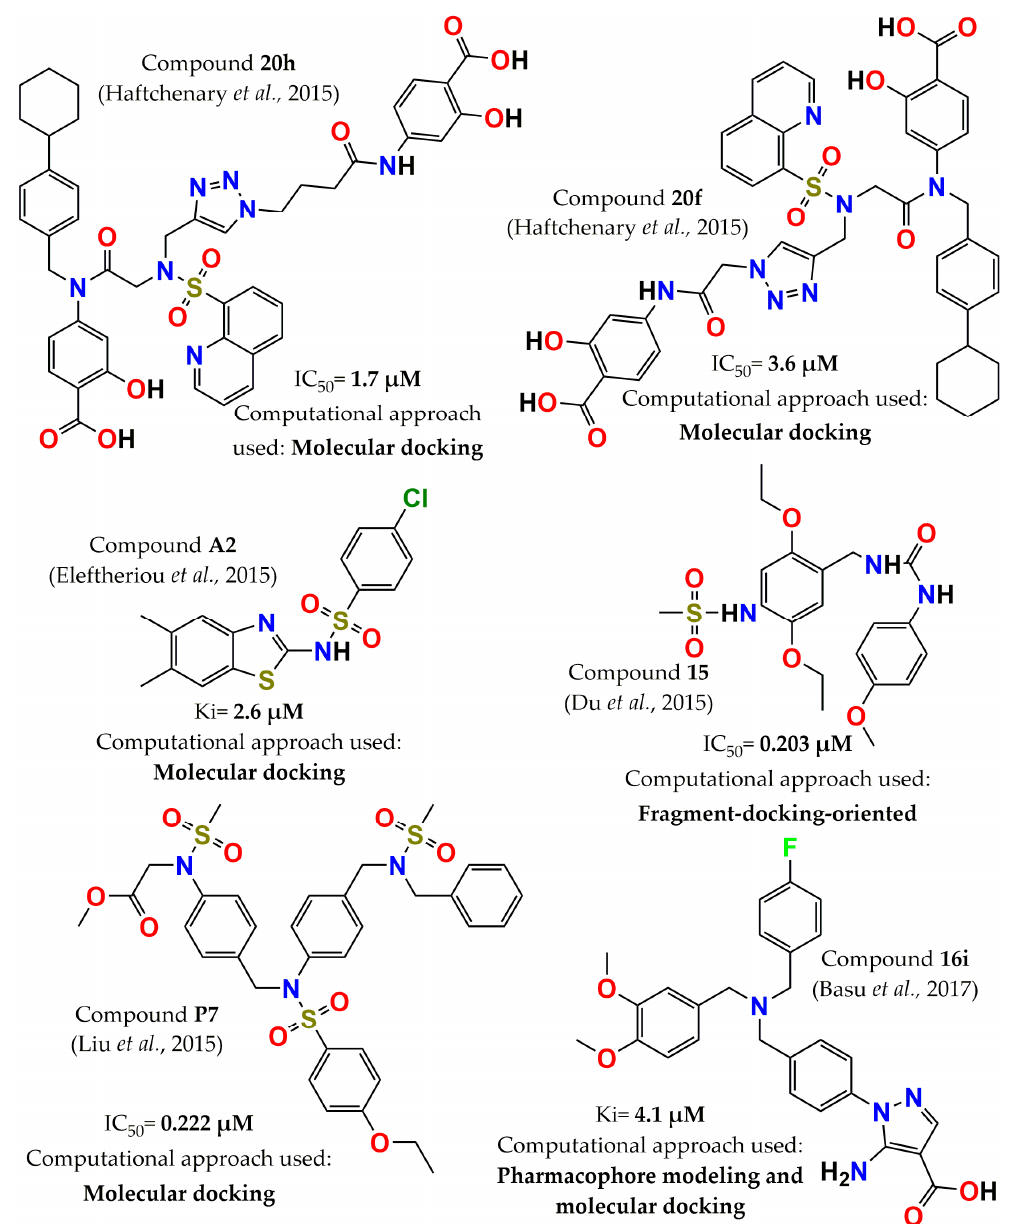
Figure 8. Structure of the most potent PTP1B inhibitors reported between 2015 and 2017 discovered through computational approaches.